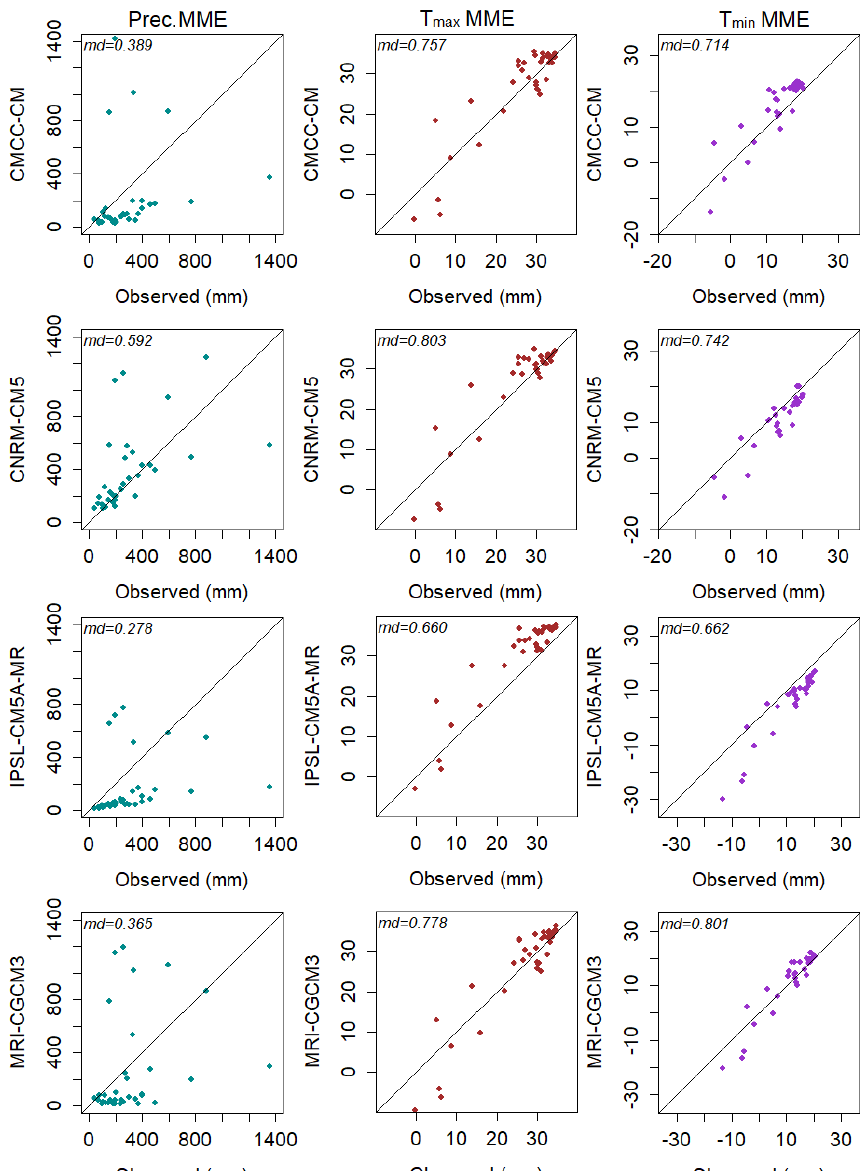
Figure 5. Scatter of spatially averaged annual P , T max , and T min of four lowest ranked GCMs plotted against GPCC P , CRU T max , and CRU T min for the period 1961 to